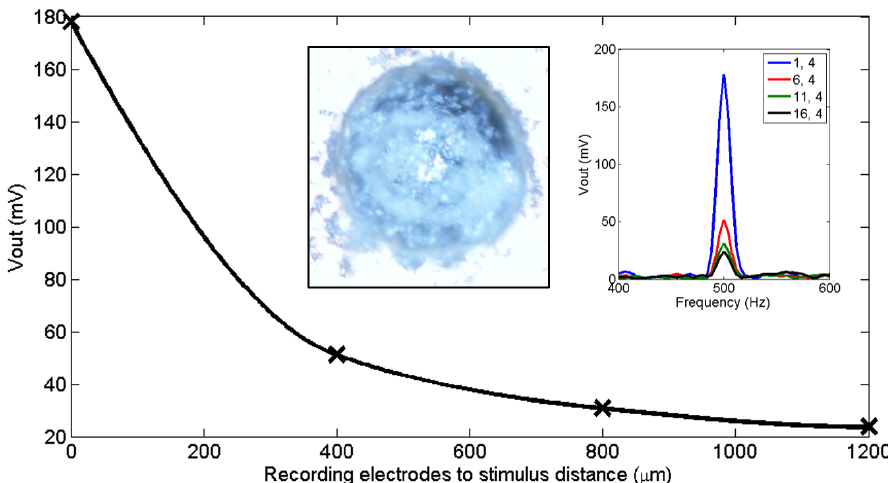
Figure 12. Measured output voltage amplitude with respect to the distance between the recording electrodes and the stimulation electrode. The inset on the right shows the output frequency spectrum, and the inset on the left shows a white substance built up on the surface of a gold plated C4 after electrical testing with the in vitro testing